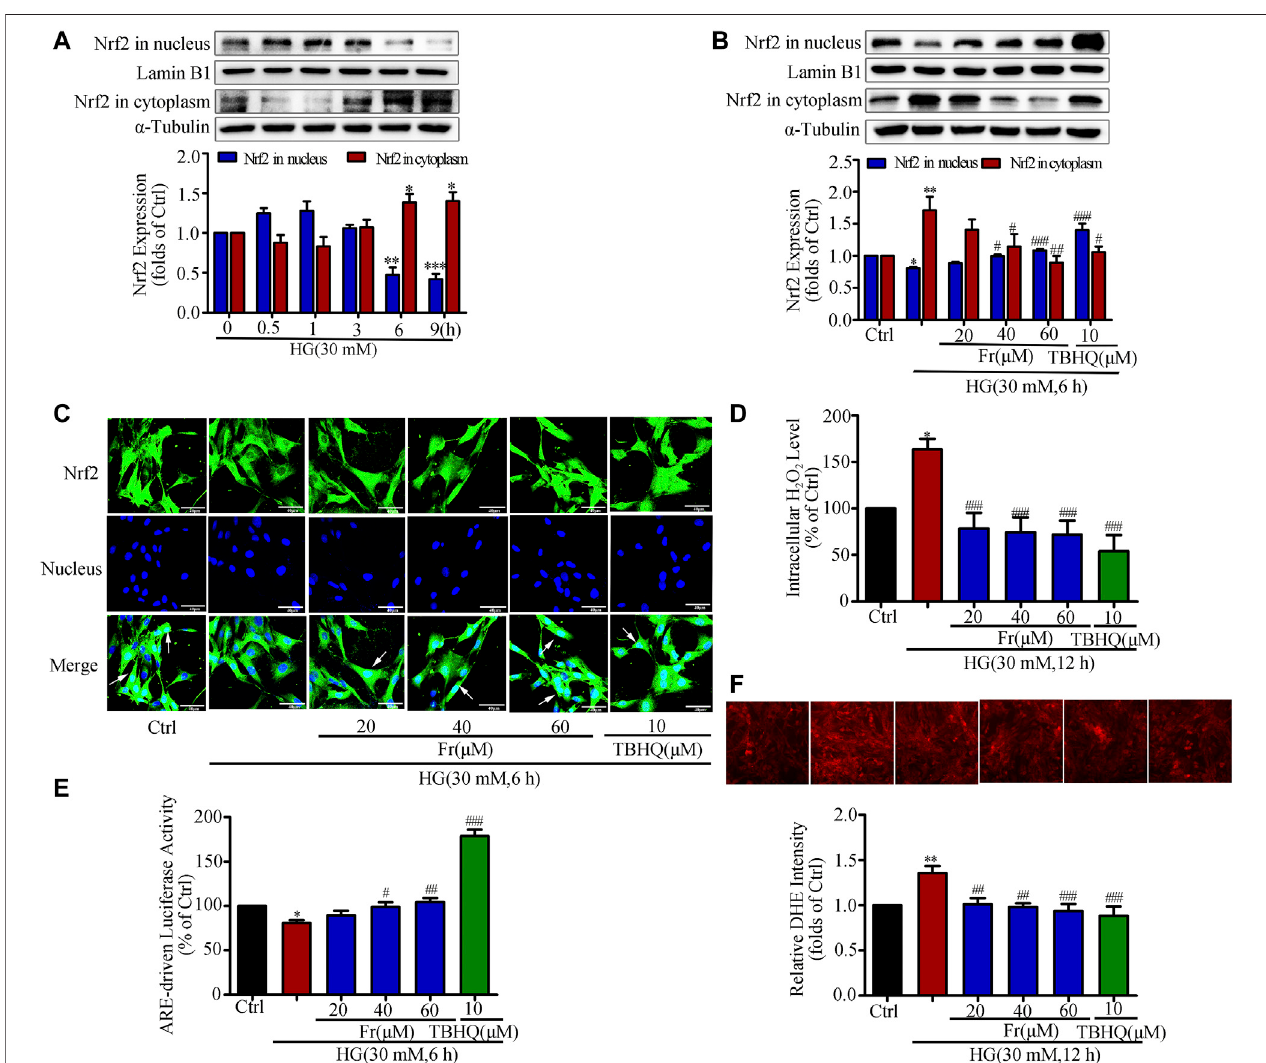
FIGURE 2 | Fr inhibited oxidative stress by activating the Nrf2/ARE pathway in HG-induced GMCs. (A) The western blot results showed the expression of Nrf2 in the nucleus and cytoplasm. * p < 0.05, ** p < 0.01, *** p < 0.001 vs . 0 h. (B) Western blot analysis of nuclear and cytoplasm Nrf2 in GMCs treated with HG and Fr for 24 h * p < 0.05, ** p < 0.01 vs . Ctrl; # p < 0.05, ## p < 0.01, ### p < 0.001 vs . HG. (C) The subcellular distribution of Nrf2 in GMCs was measured by immuno fl uorescent staining (×600 magni fi cation). Bar: 40 μ m. Green fl uorescence indicated localization of Nrf2. (D) Intracellular H 2 O 2 level was provoked by high glucose and Fr treatment